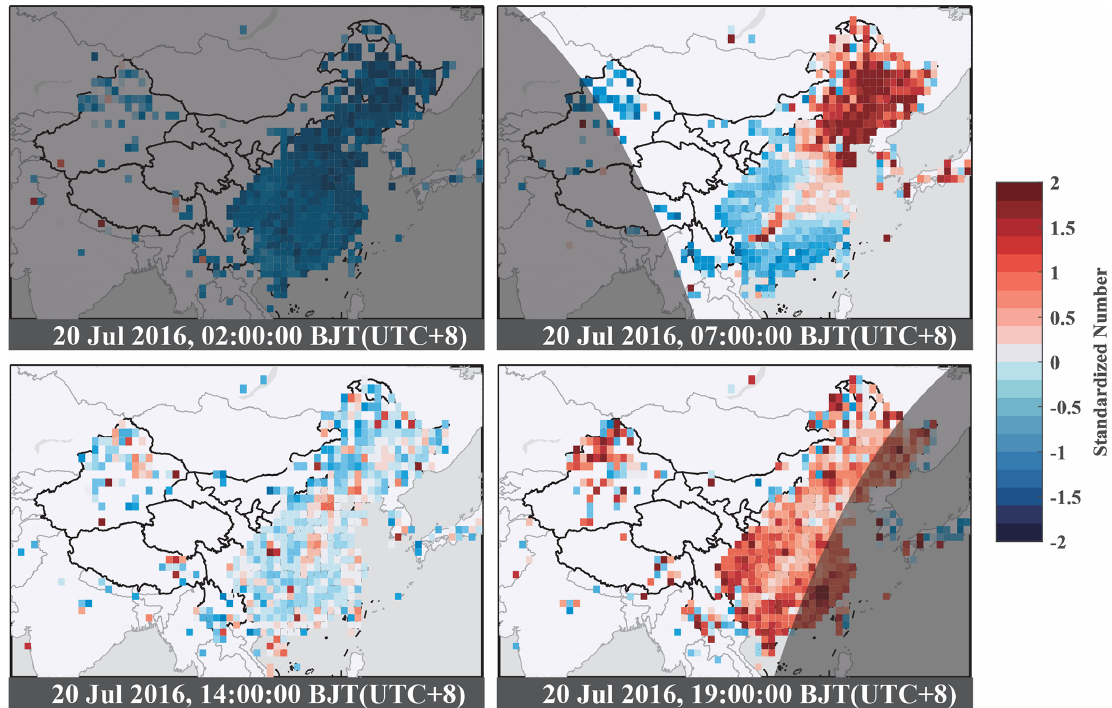
Figure 6. Spatial distribution of the standardized value of the data number at each site for each hour on 20 July 2016. The time is shown in Beijing standard time (BJT). The standardized number is defined as the difference between the data number in this grid at a specific hour and daily mean of the number divided by the standard deviation of the number. The dark gray color fill stands for the region in nighttime. Warm colors indicate a rise in data volume, while cool colors indicate a